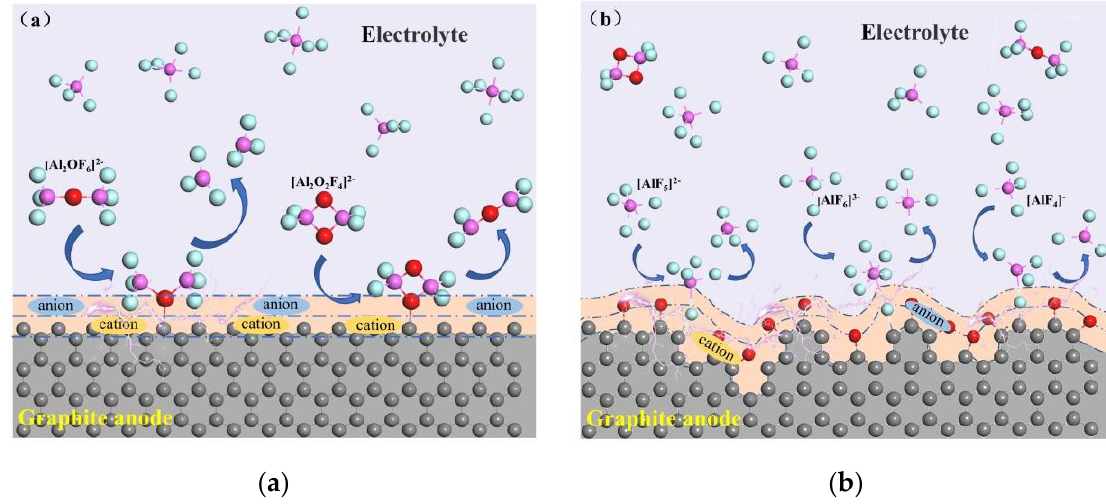
Figure 2. Schematic diagram of electrochemical reaction at the interface of carbon anode: ( a ) [O] 2 − preferential discharge stage (when the concentration of alumina in molten salt is high, [O] 2 − discharges preferentially on the anode surface); ( b ) [O] 2 − , [F] − co-discharge stage (Concentration of alumina in molten salt decreases, but the cell voltage does not increase significantly, reaching the anode effect. O and F ions discharge together on the anode